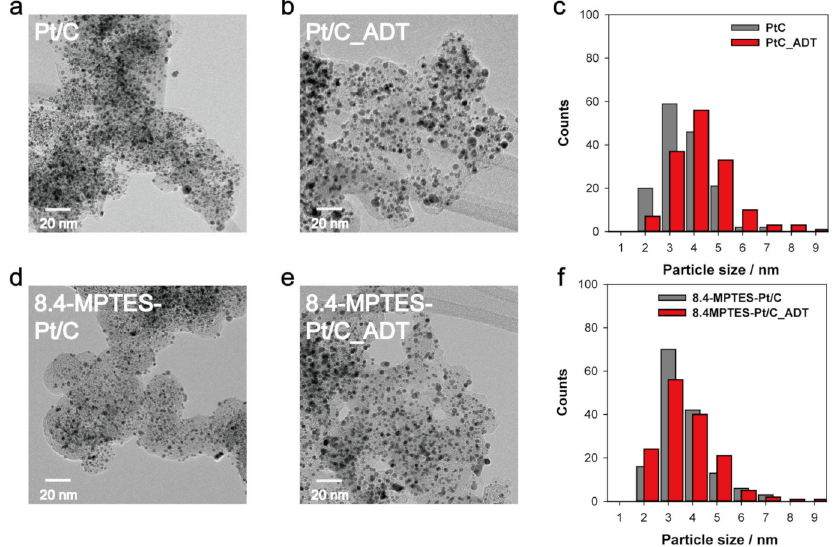
Figure 6. High-resolution transmission electron microscopy (HR-TEM) images and particle size distribution histograms before and after ADT for ( a – c ) Pt/C and ( d – f )